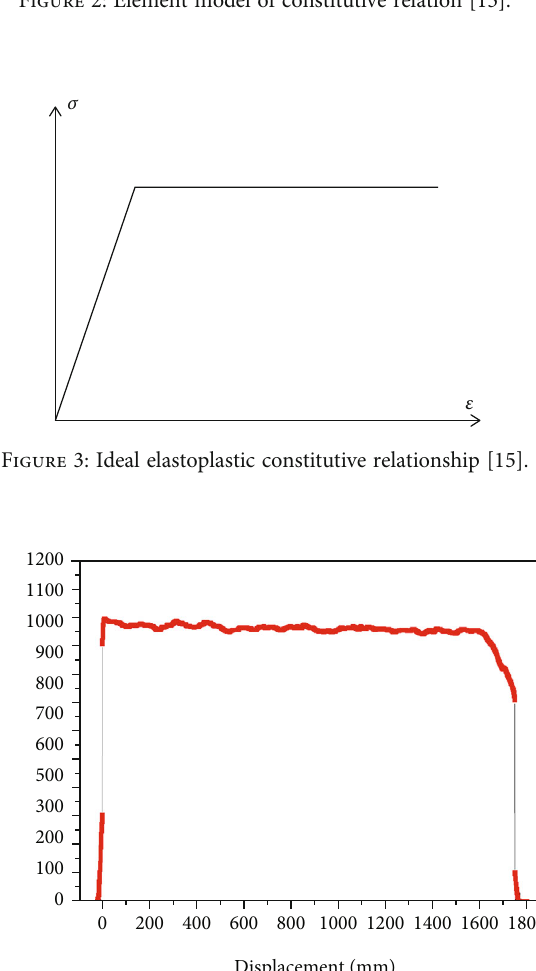
Figure 2: Element model of constitutive relation [15].